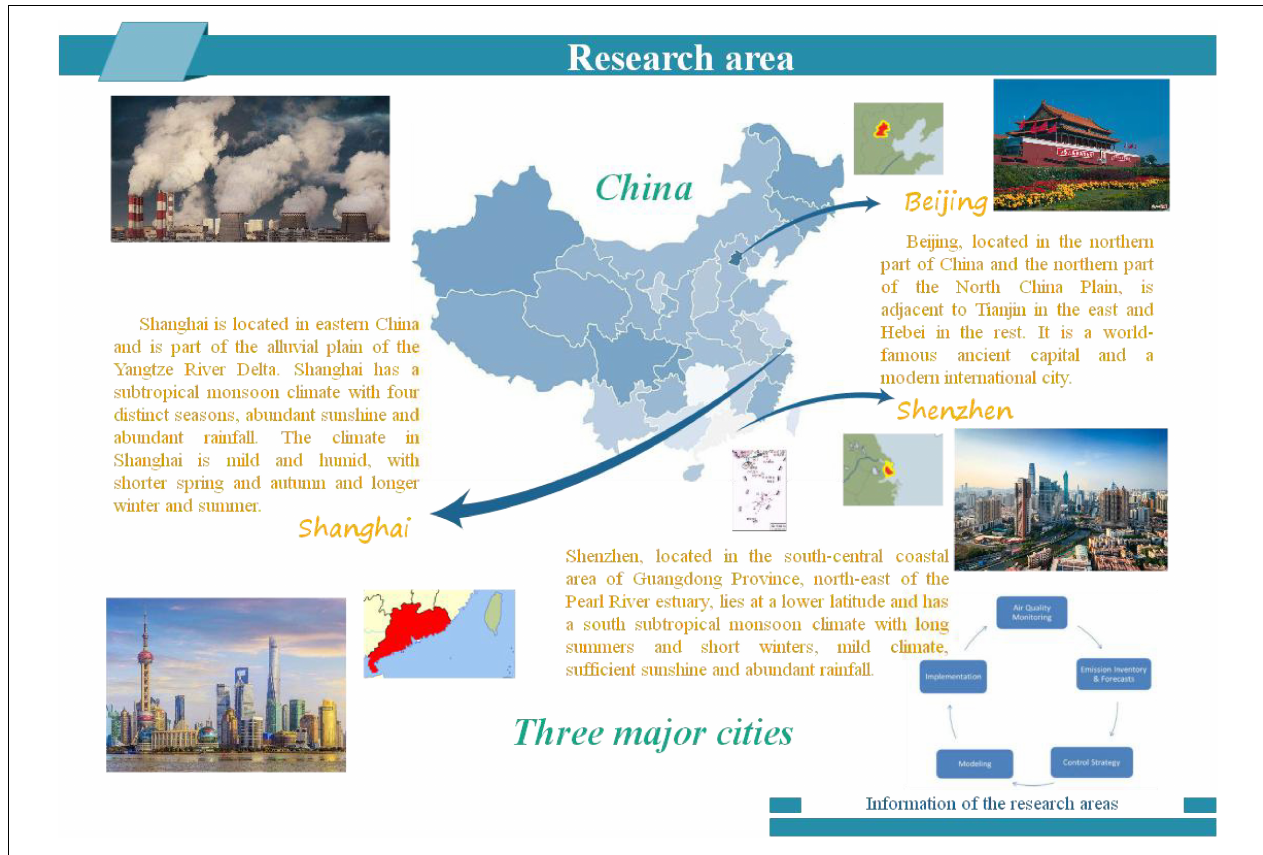
FIGURE 2 | Information of the research